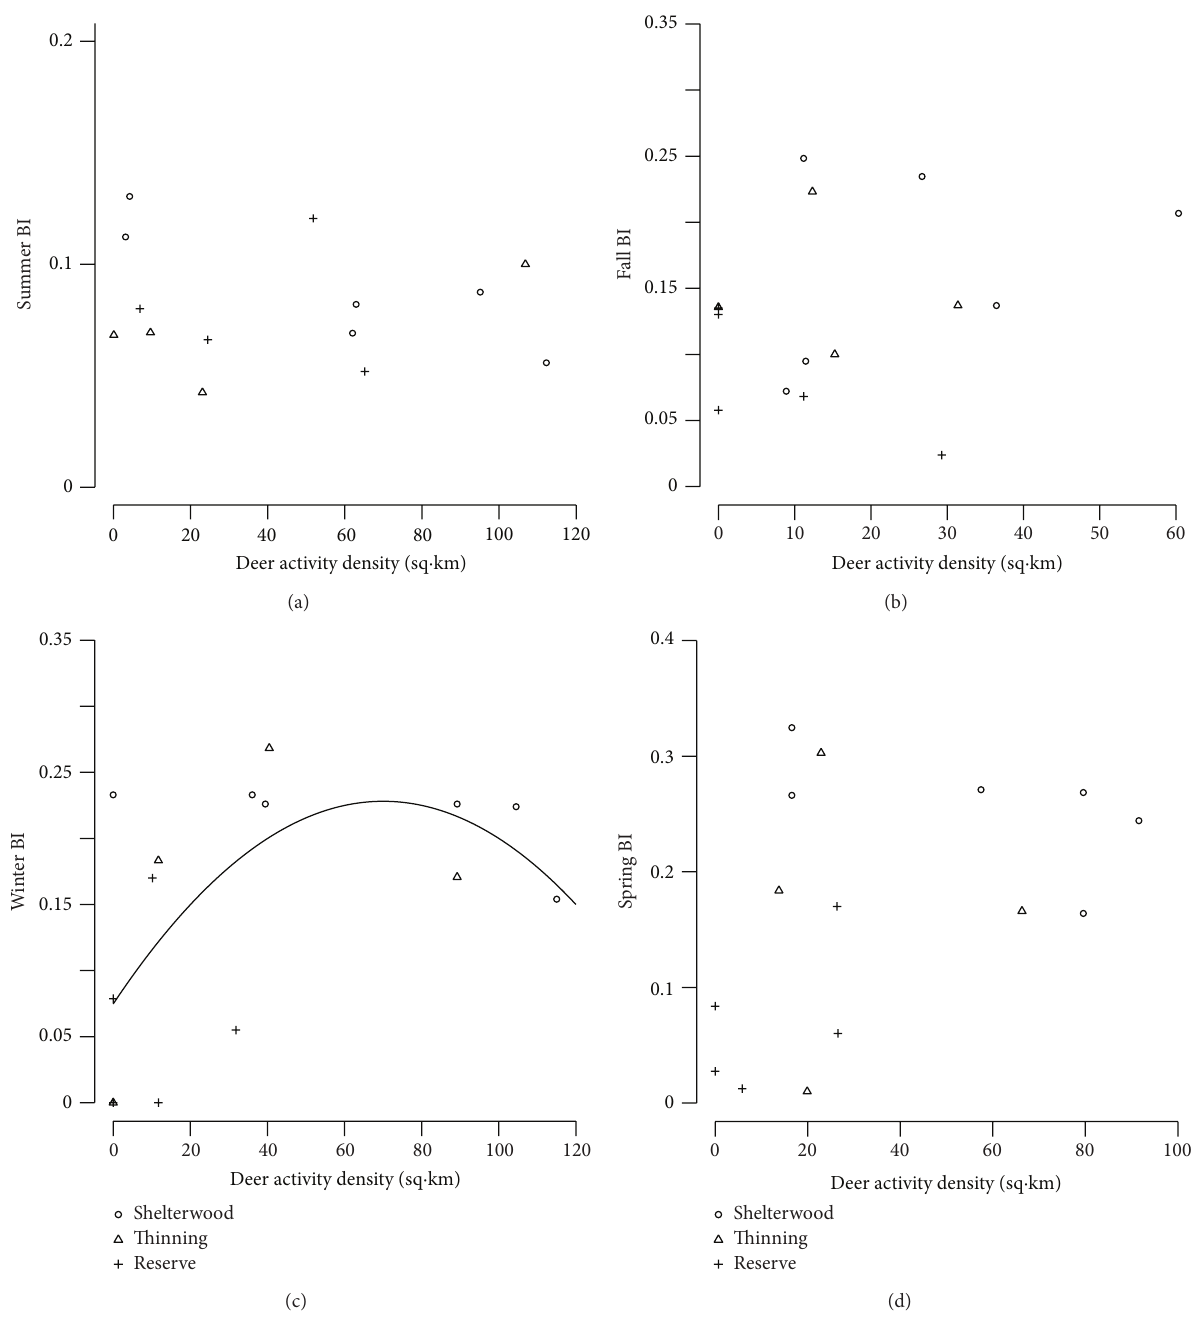
Figure 4: Relationship between activity deer density and browse index (BI) at YMF for (a) the summer (May–August), (b) fall (September– October), (c) winter (November–January), and (d) spring seasons (February-March). Regression lines are provided when significant models were